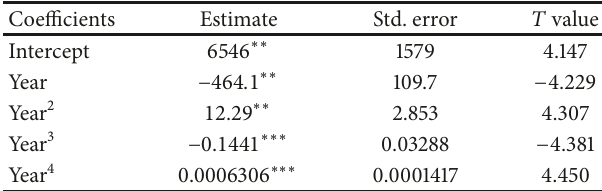
Table 6: Factor scores.